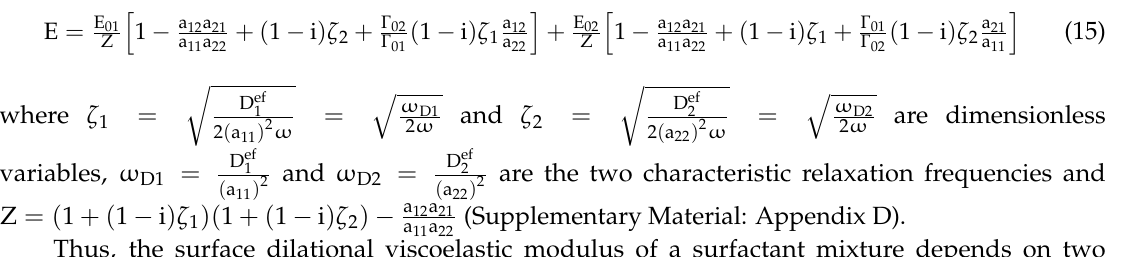
are the two characteristic relaxation frequencies ( a 22 ) 2